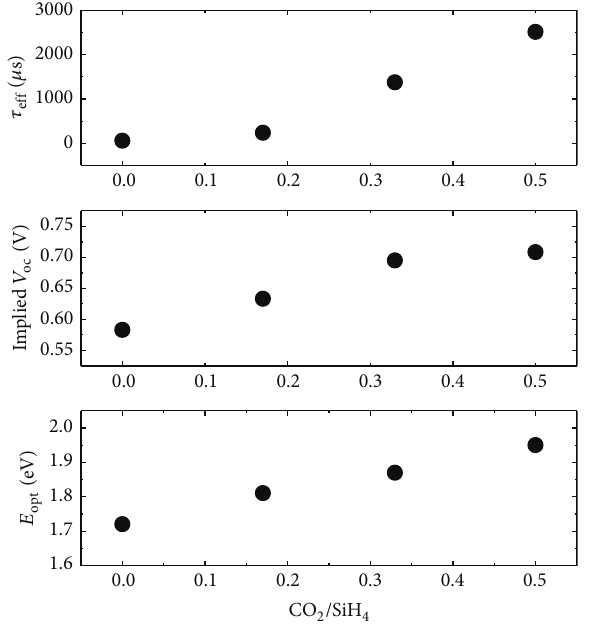
Figure 2: Effective lifetime ( 𝜏 ) of n-c-Si passivated by the i-a- eff of the i-a-SiO:H films and SiO:H films, which implied that 𝑉 oc ) of the i-a-SiO:H films are a function of the optical bandgap ( 𝐸 opt CO 2 /SiH 4 ratio.